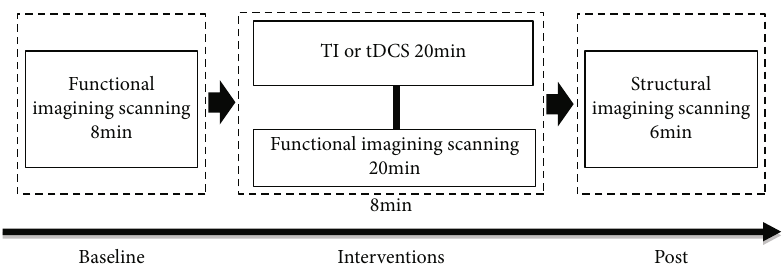
Figure 1: Experimental protocol. The experiment consists of baseline, intervention, and postphase. In the baseline, participants attended an 8min functional scanning session. In the interventions phase, participants attended 20min TI or tDCS stimulation and functional scanning simultaneously. In the post phase, participants were scanned 6 min for structural images.